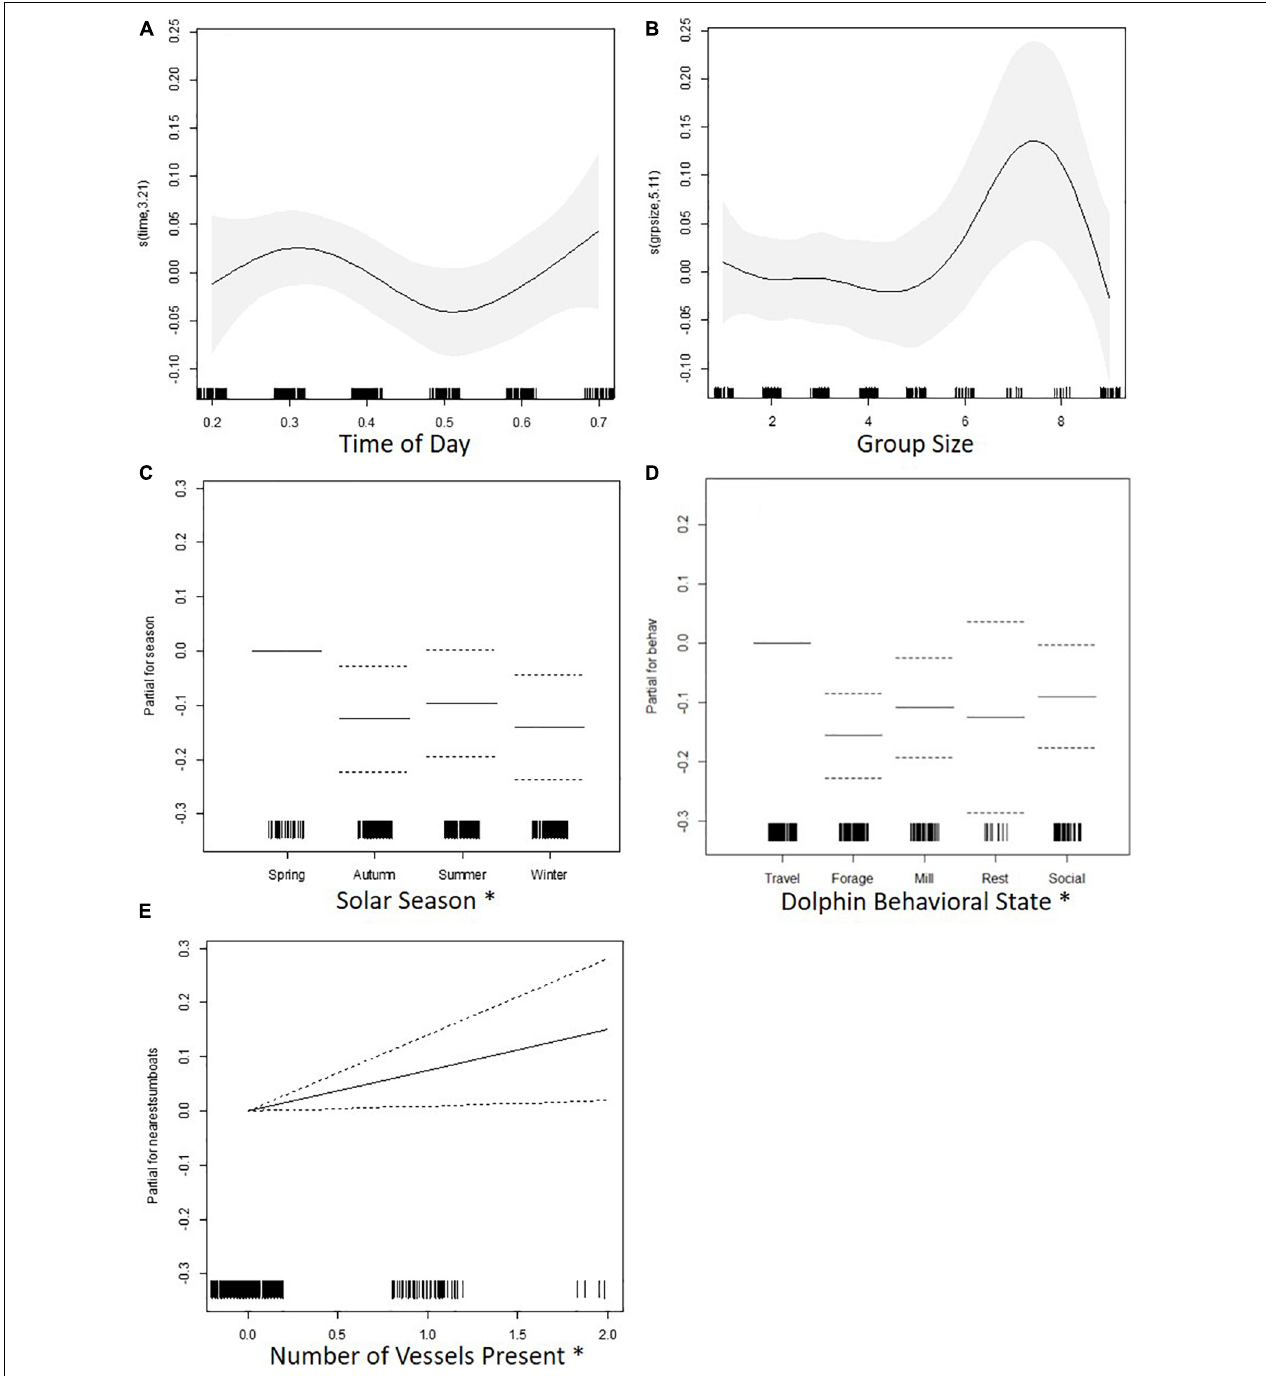
FIGURE 4 | Charts for the partial contribution of individual explanatory variables in the fitted GAM for swimming speed. Charts include: (A) time of day, (B) dolphin group size, (C) solar season, (D) dolphin behavioral state, and (E) number of vessels present. The rugplot along the x -axis indicates the density of observations for each factor. On the y -axis, values > 0 indicate a positive correlation with swimming speed, values < 0 indicate a negative correlation, and a value of 0 indicates no effect. Signif. codes: “*” 0.05; “ · ” 0.1.